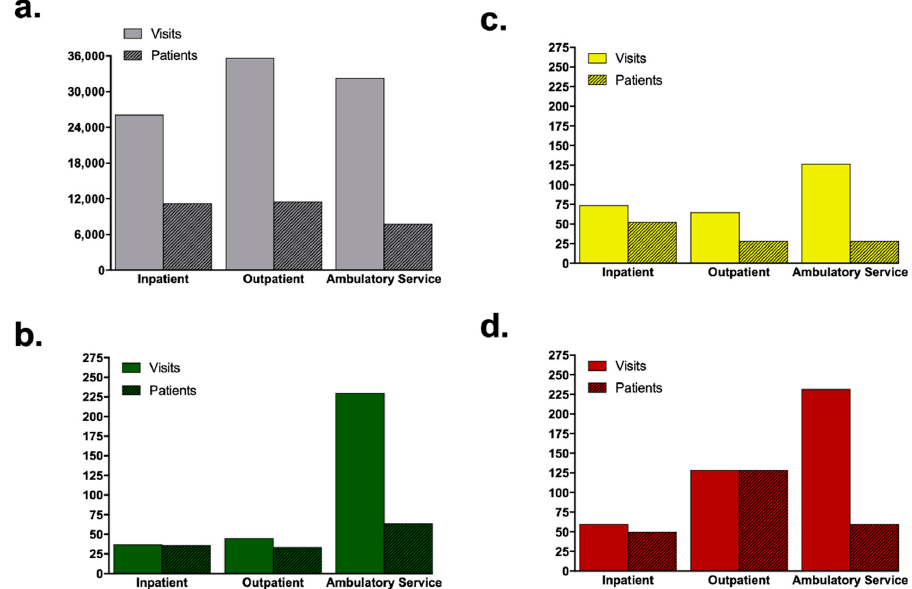
Figure 3. Distribution of the Visits and Patients by Visit Type in the Large Animal Clinic. The X-axis shows the three visit types: Ambulatory Service, Outpatient and Inpatient; Visits are depicted in solid color and patients are in color with pattern: ( a ) All equids (grey), ( b ) standard donkeys (green), ( c ) miniature donkeys (yellow), and ( d ) mules (red). Table 1. Ratio of Number of Visits per Patient for Visit Types at the Large Animal Clinic.